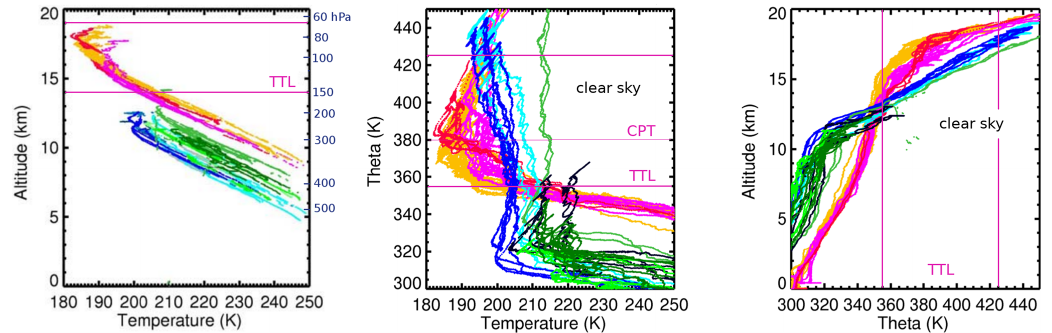
Figure 2. Left panel: temperature vs. altitude inside of cirrus clouds (adopted from Schiller et al., 2008). Middle panel: temperature vs. po- tential temperature (cid:50) . Right panel: clear-sky (cid:50) vs. altitude. Plotted are 28 flights from the database, with blueish colors for Arctic, greenish colors for midlatitude, and reddish colors for tropical observations. Magenta lines: range of the TTL (tropical tropopause layer) and tropical CPT (cold point tropopause) (after Fueglistaler et al.,